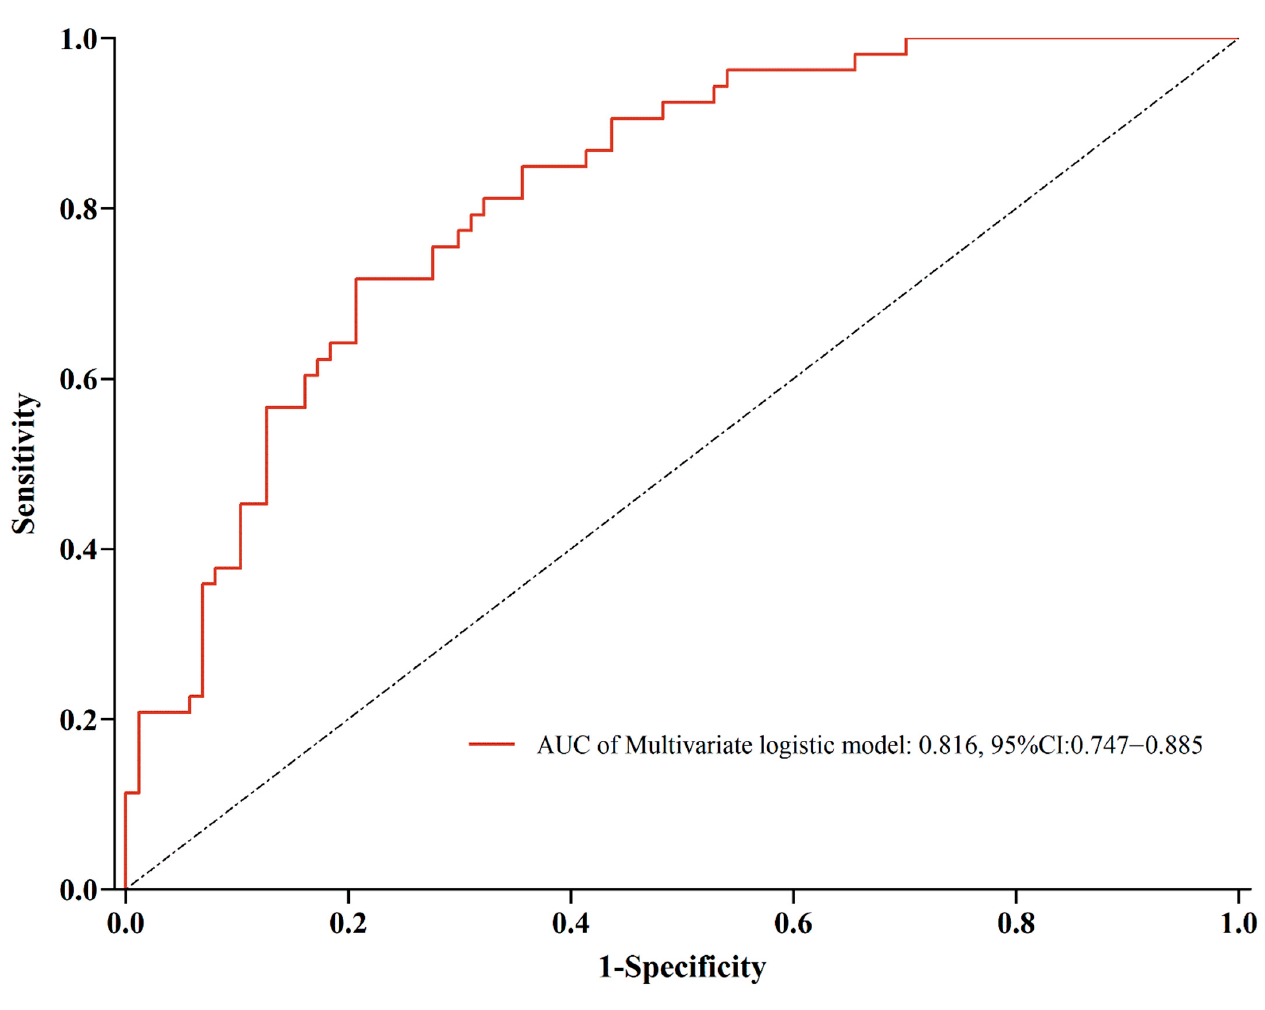
Figure 5. Receiver operating curves (ROC) for the prediction performance of the logistic regression